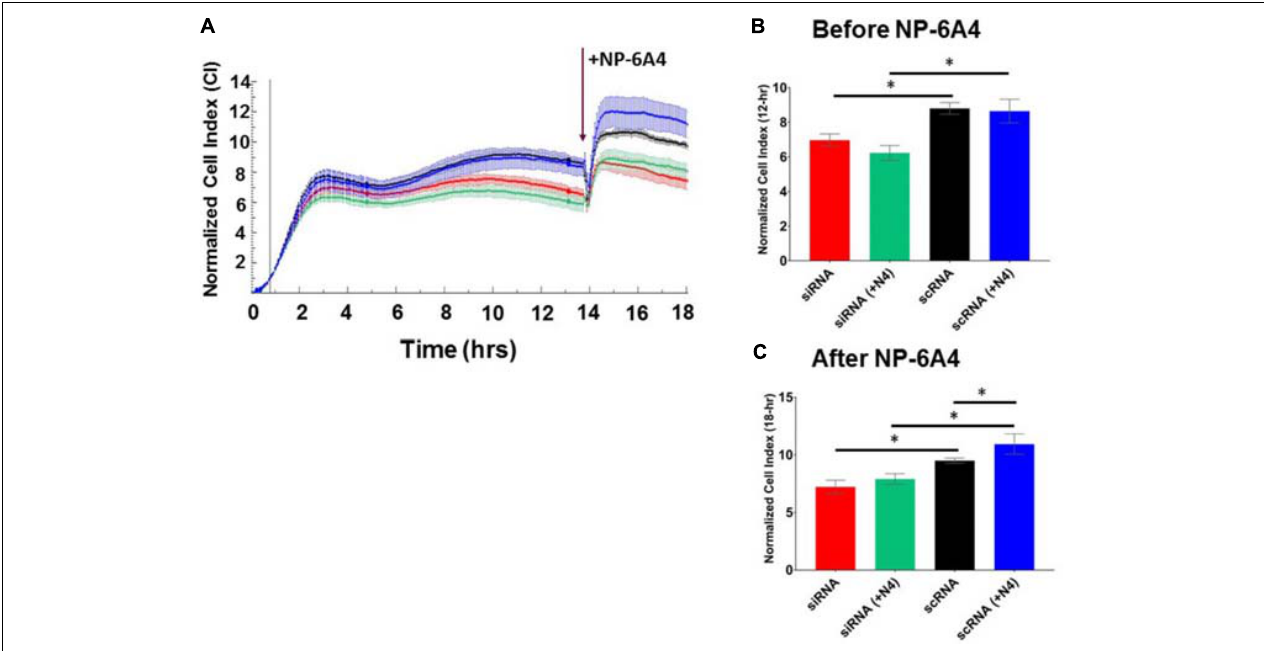
FIGURE 7 | AT2R siRNA inhibited growth properties (CI) of hCAEC both in the absence and presence of NP-6A4. (A) Cell Index curve depicting change in cell index (CI). Arrow indicates addition of NP-6A4. (B) Differences in CI after 12 h of treatment with anti-AT2R siRNA (labeled siRNA) or siRNA-Scrambled (scRNA). At this point none of the cells had been treated with NP-6A4. n = 4 per group. (C) Differences in CI approximately 4-h after the addition of NP-6A4 (20 µ M). n = 4 per group. ∗ Indicates p < 0.05 vs. CTRL using one-way ANOVA at the indicated time